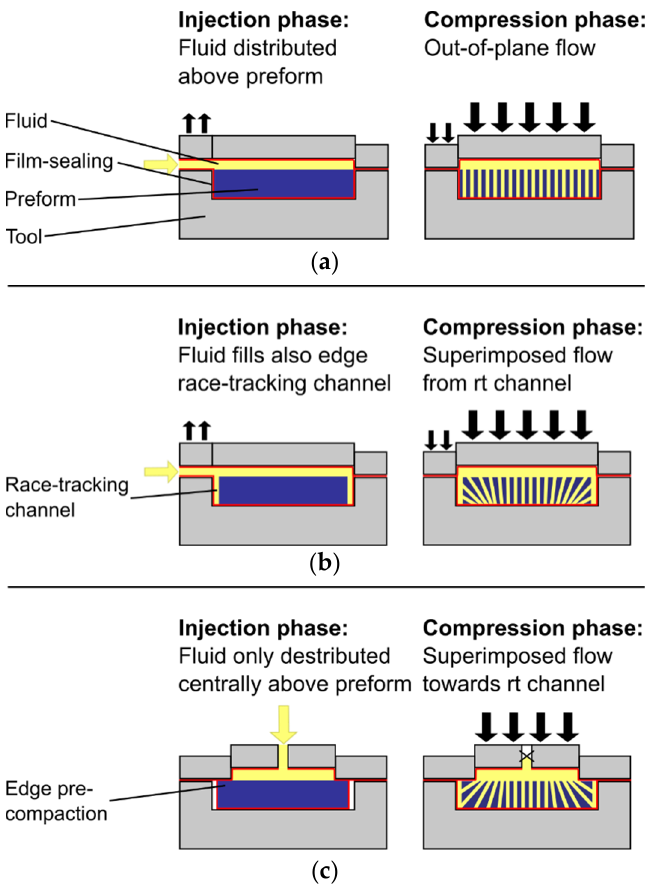
Figure 2. Hypothesized FS-CRTM flow experiment scenarios of preforms of small geometrical aspect ratio: ( a ) without edge race-tracking (rt) channel; ( b ) with edge race-tracking channel; ( c ) applying a passive flow control strategy to diminish the edge race-tracking effect.